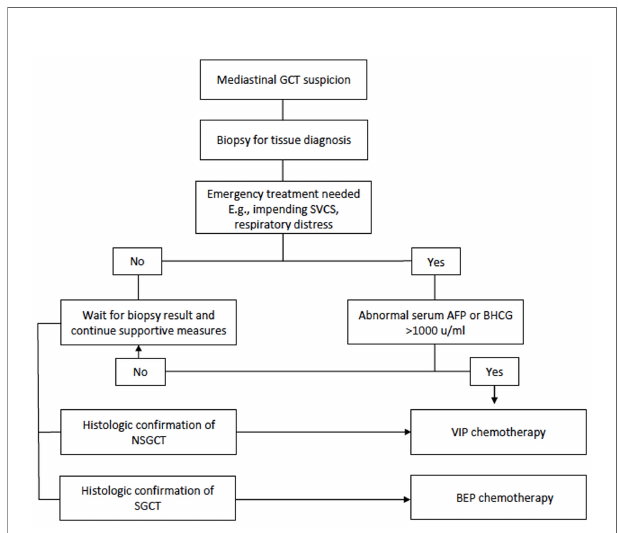
FIGURE 1 | Initial approach of the patient with mediastinal germ cell tumor.